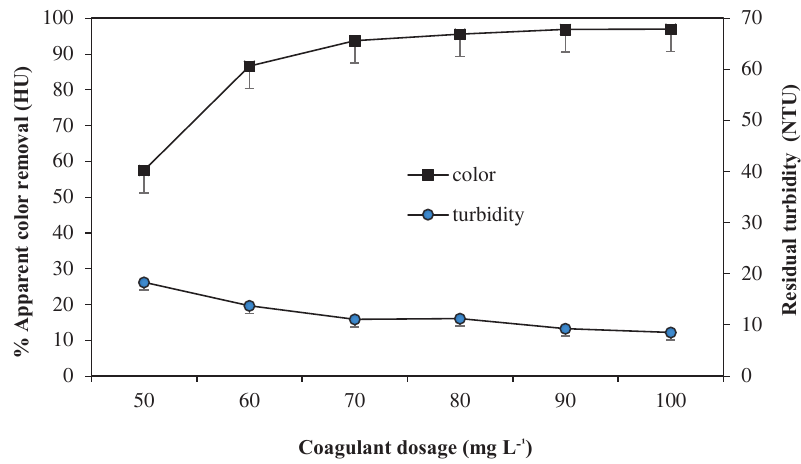
Figure 2 - Residual turbidity and apparent color removal rate of Pinheiros River water treated with PGα21Ca (Vs 1 cm min -1 ) in the dry